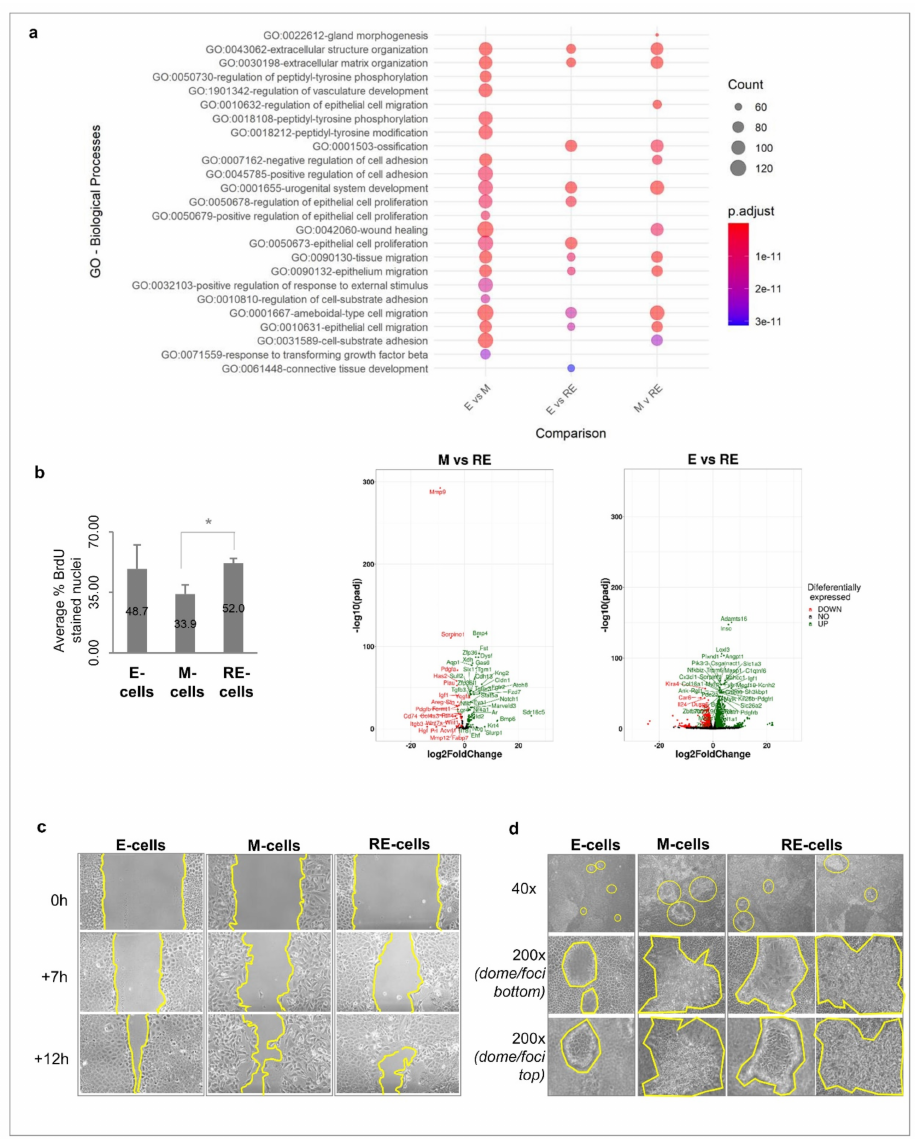
Figure 3. RE cells exhibit a high proliferation rate, heterogeneous migration pattern and focus formation assay. ( a ) Biological processes deregulated across comparisons (padj < 0.05), displaying that RE cells have a unique biological identity different from both E and M cells. ( b ) Cell proliferation analysis in terms of percentage of BrdU stained nuclei (per total number of DAPI-stained nuclei, n = 3, where * = p < 0.05 for MvsRE comparison). Volcano plots show upregulation of proliferation-related genes in RE cells when compared to M and E cells. ( c ) RE cells exhibit mixed cell migration patterns, resembling both E and M cells. Wound healing brightfield images of E, M and RE cells were taken at different timepoints (0, 7 and 12 h, 100 × ). ( d ) Brightfield images of E, M and RE cells grown for 21 days in plastic and normal culture medium. Top panel shows general view of the 21-day cultured E, M and RE cells (40 × ). Middle panel shows bottom layer of non-transformed cells surrounding dome-like structures or foci (200 × ). Bottom panel shows top layer of dome-like structures or foci obtained after 21 days of culture of E, M and RE cells (200 ×